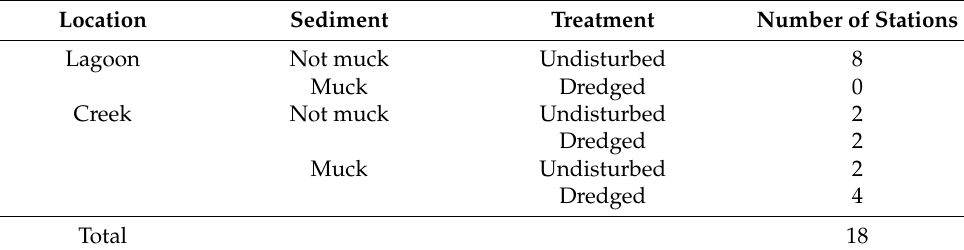
Table 1. Sampling design showing the number of stations in categories used in